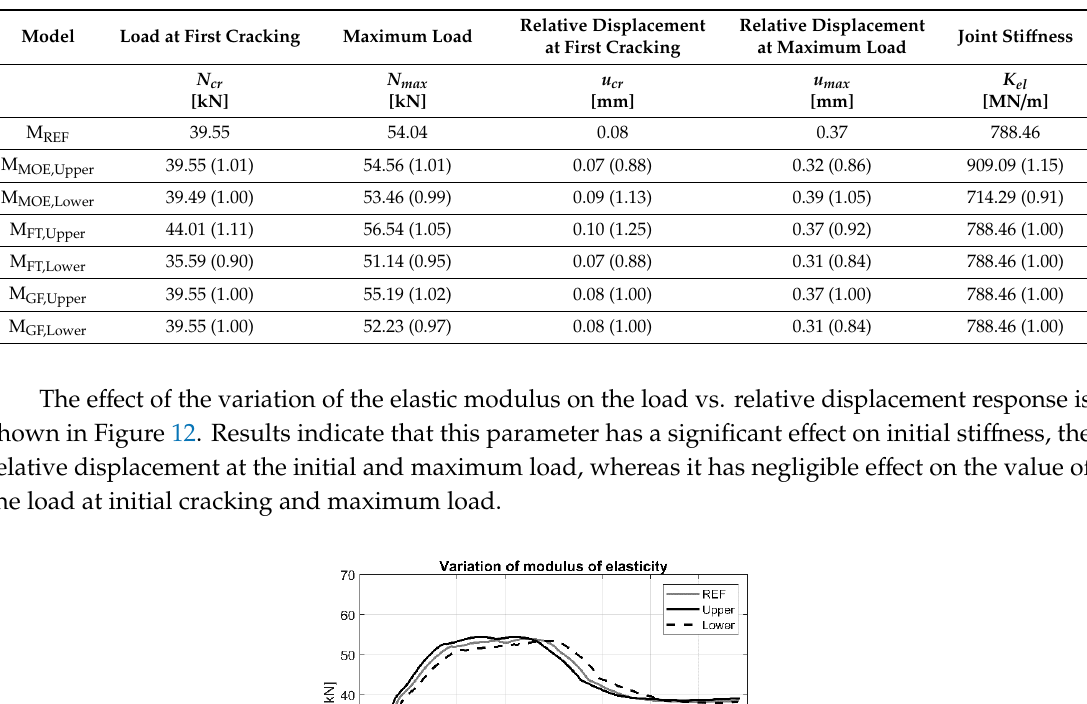
Figure 13. Load vs. load-relative displacement curves for the variation of tensile strength of AAC. Figure 14. Load vs. load-relative displacement curves for the variation of fracture energy of AAC. 5. Conclusions In this paper, a nonlinear two-dimensional finite element model was developed to simulate the structural behaviour of traditional joints between walls made of AAC masonry units. The finite element model was validated using the test results of an experimental campaign involving testing of six T-shaped, monosymmetric samples with traditional joints between walls loaded in shear. A sensitivity study of several critical input material parameters of AAC on the behaviour of the walls was also conducted. From the performed studies, the following conclusions are drawn: •